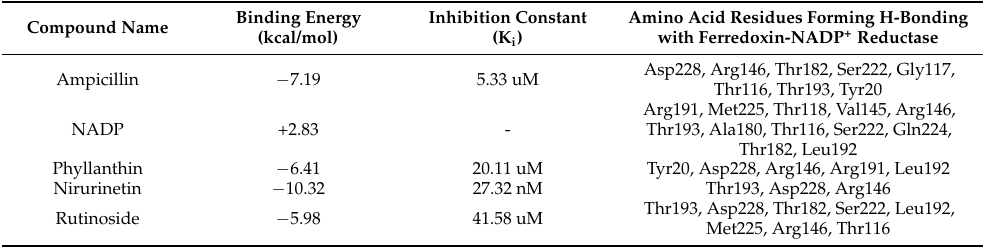
Table 1. Docking results of ligands with ferredoxin-NADP + reductase of Xanthomonas axonopodis